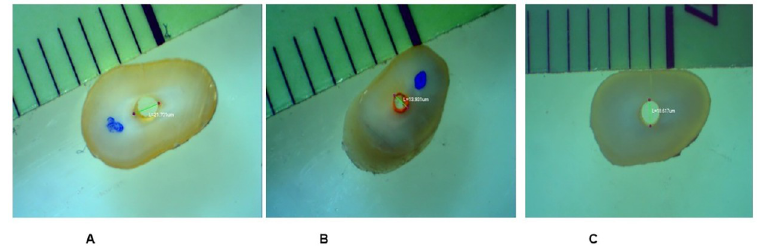
Fig 3. Failure type A) mixed, B) cohesive, C)